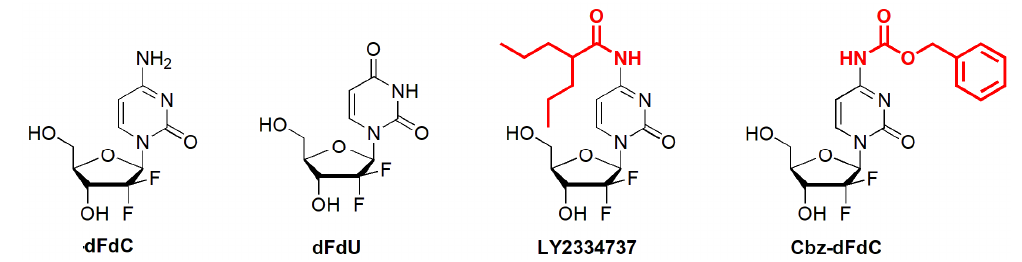
Figure 1. The structures of Cbz-dFdC; dFdC; dFdU; and LY2334737.